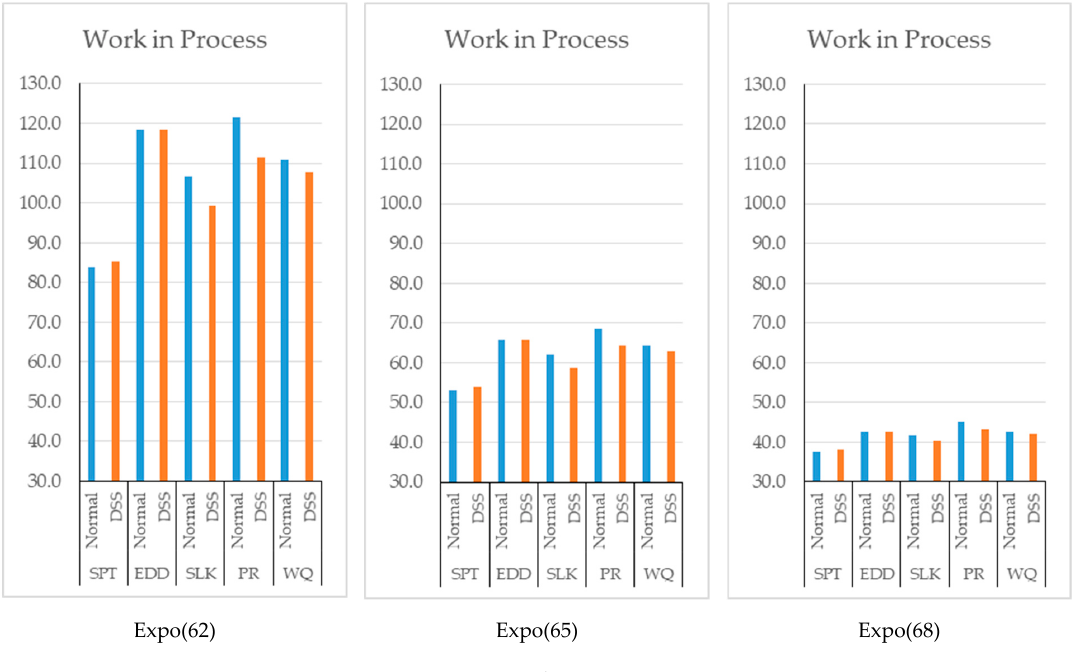
Figure 7. Work in Process.